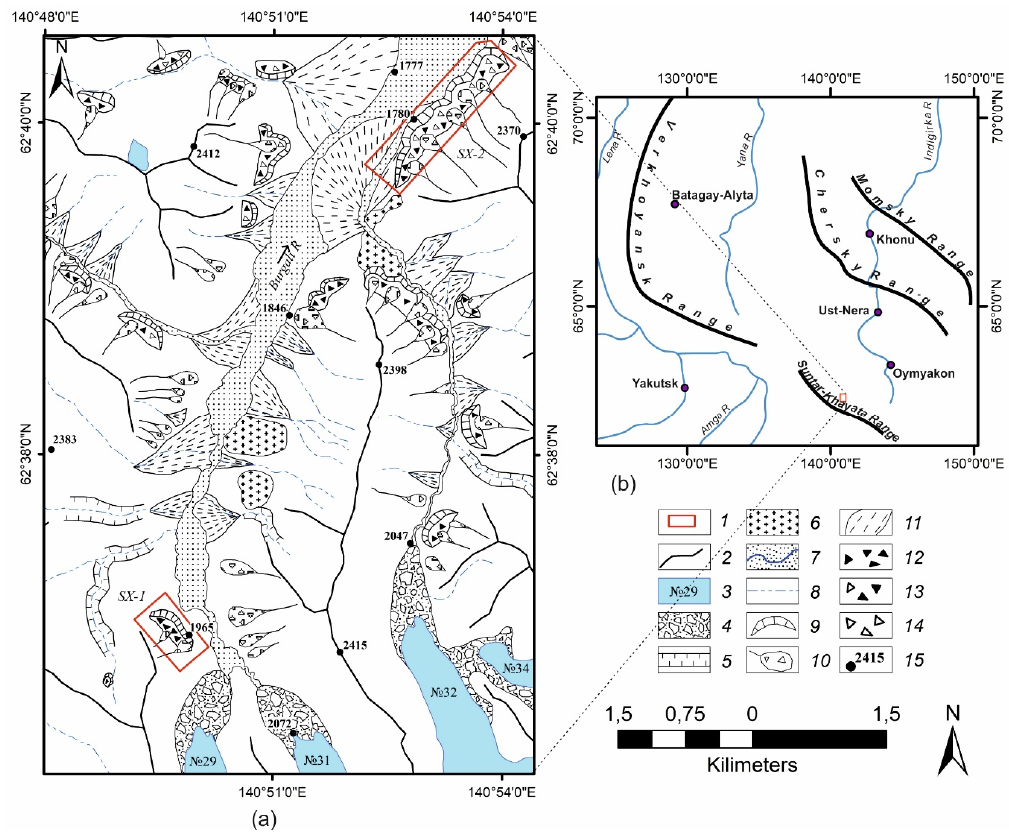
Figure 8. The key research site on the Suntar-Khayata Range is marked with a red square ( b ). Glacial-periglacial complexes in the Burgali River valley ( a ). 1—footslope multi-lobe rock glacier № SX-1 and SX-2 ; 2—Range crests; 3—glaciers as numbered according to the USSR Glacier Inventory; 4—Late Holocene moraines; 5—erosional cliffs; 6—riegels; 7—floodplain and channel of modern streams; 8—